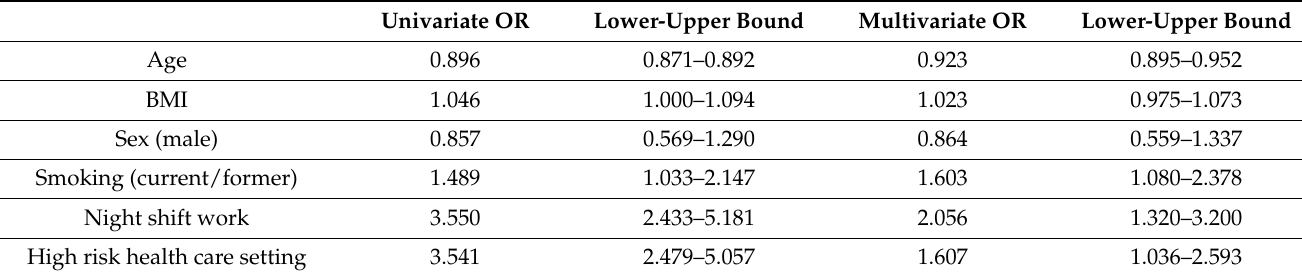
Table 2. Univariate and multivariate analyses of the study